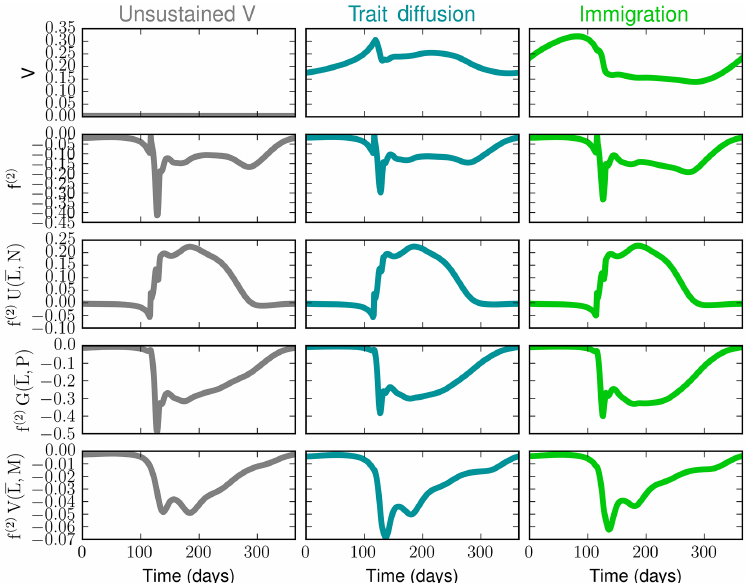
Figure 8. Components of the size variance ( V ), where f ( 2 ) is the second derivative of the fitness function with respect to the trait; f ( 2 ) U(L, N ) , f ( 2 ) G(L, P ) , and f ( 2 ) V (L,M) are, respectively, nitrogen uptake, zooplankton grazing, and phytoplankton sinking compo- nents of f ( 2 )